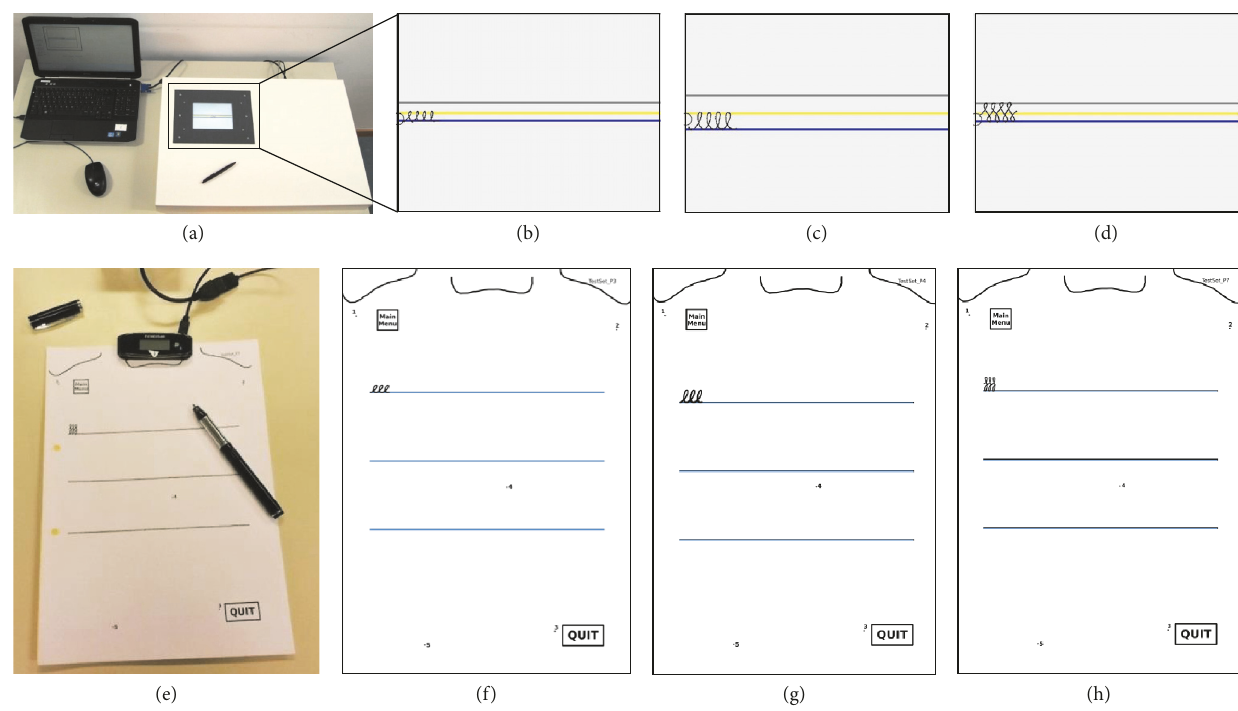
Figure 1: Touch-sensitive tablet and feedback pen system . (a) Setup of the tablet; (b–d) examples of the small trained (b), large trained (c), and untrained (d) task with visual cues. It has to be noted that testing was performed in the absence of the yellow (middle) and upper (grey) line. (e) Setup of the pen, receiver, and paper; (f–h) examples of the test sheets for the small trained (f), large trained, (g) and untrained task (h).